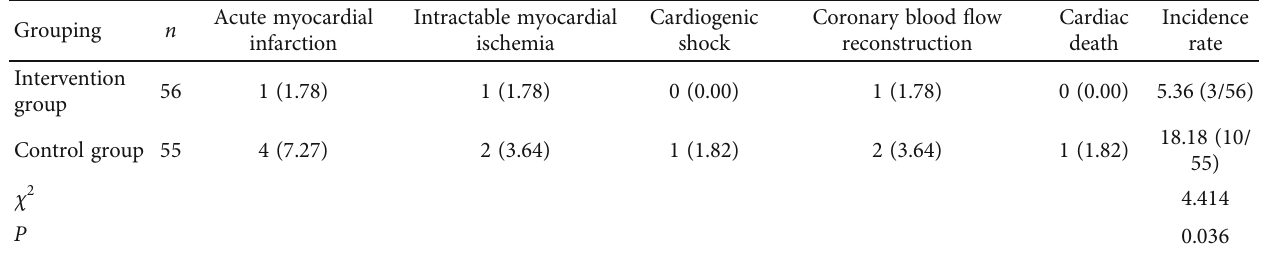
Table 4: Comparison of adverse cardiac events of both groups ½ n ð % Þ(cid:2)